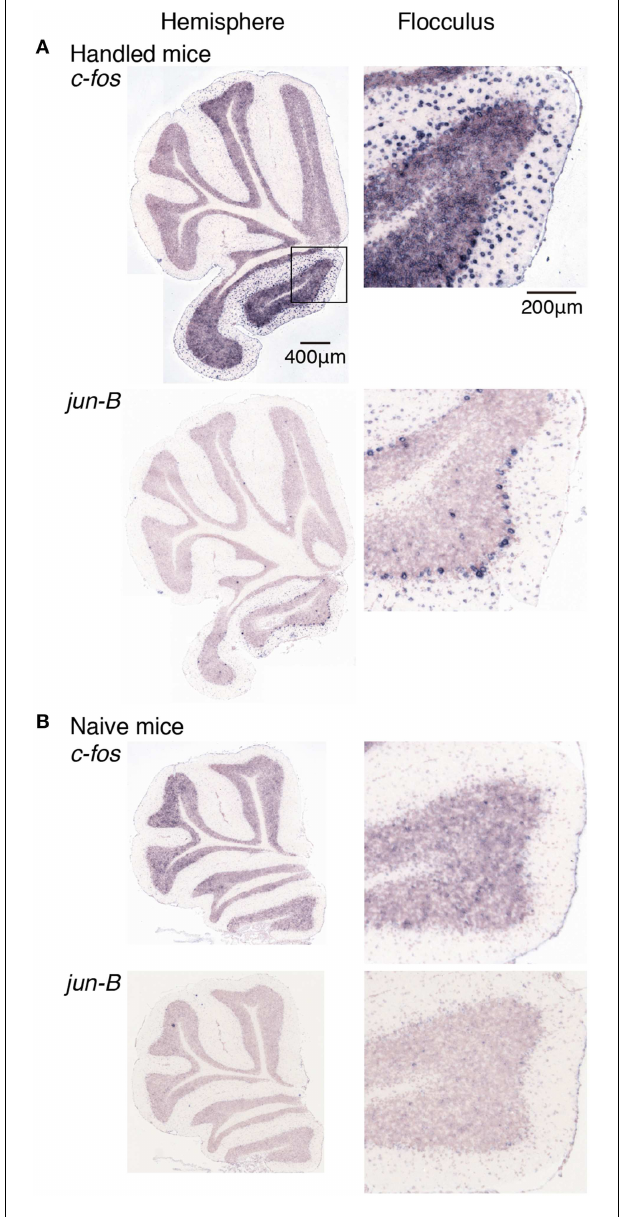
FIGURE 6 | Expression levels of c-fos and jun-B mRNAs in the cerebellum of mice handled for a week. (A) Mice handled for a week (see Materials and Methods). (B) Naive mice that were allowed to move freely but were not handled by humans. Sections of the hemisphere that showed the highest signal intensity for each gene are shown (left panel), Right panels show magnified images of floccular signals enclosed in a box in the top image of the left panel.